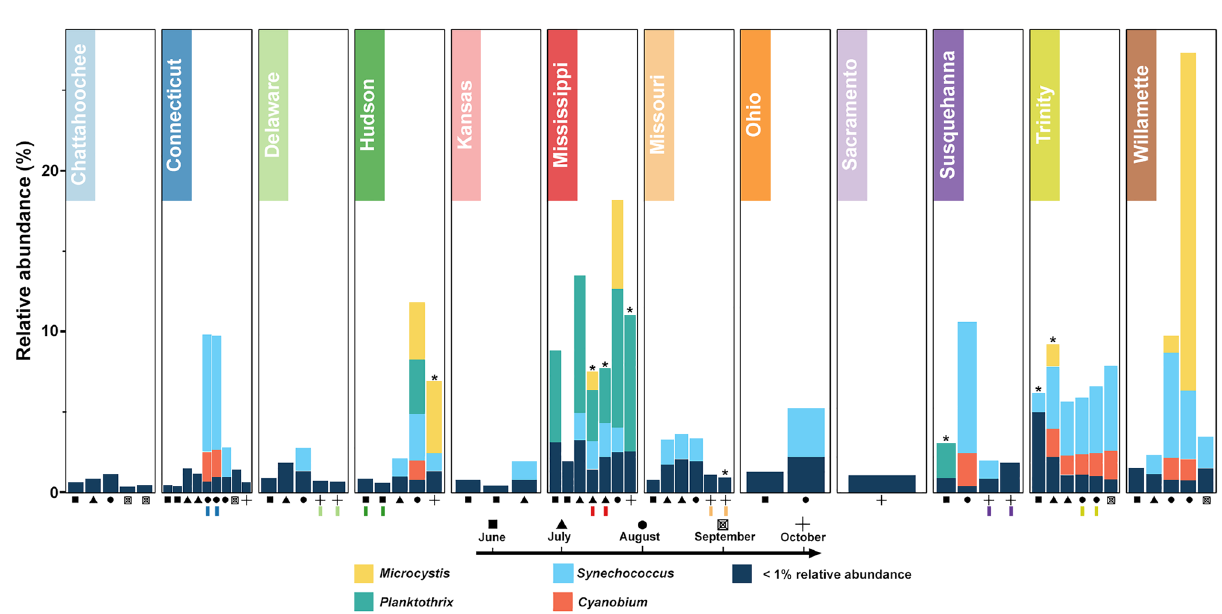
Figure 3. Cyanobacterial genera. Relative abundance of cyanobacterial genera occurring above 1% relative abundance threshold (compared to all bacteria) in each U.S. river at each time point sampled in 2019. Samples are grouped by river (top) and arranged by date (shapes under each bar—see legend below shapes). Samples taken sequentially (replicates) are indicated by colored hashes below date shape. Samples with detectible microcystin toxin levels are indicated by asterisk above bar. Bar color indicates genera as shown by